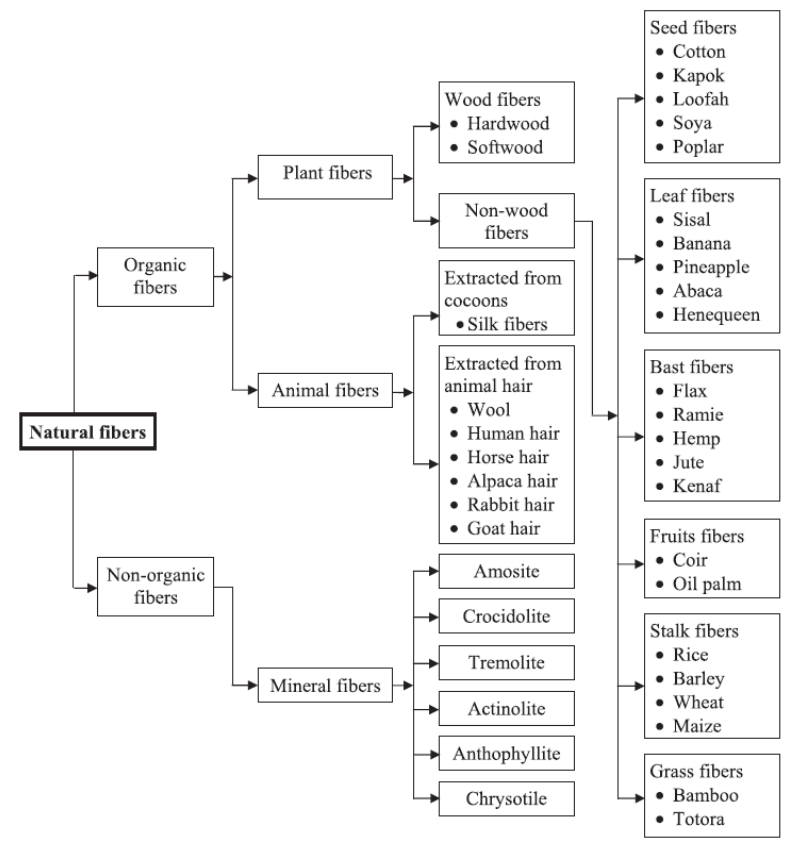
Figure 7. Classification of natural fibre